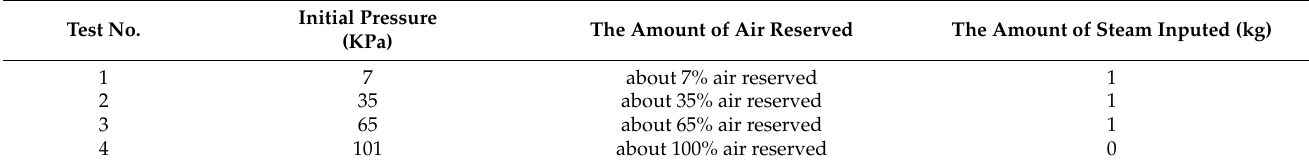
Table 3. Composition of the initial drying medium in tests.